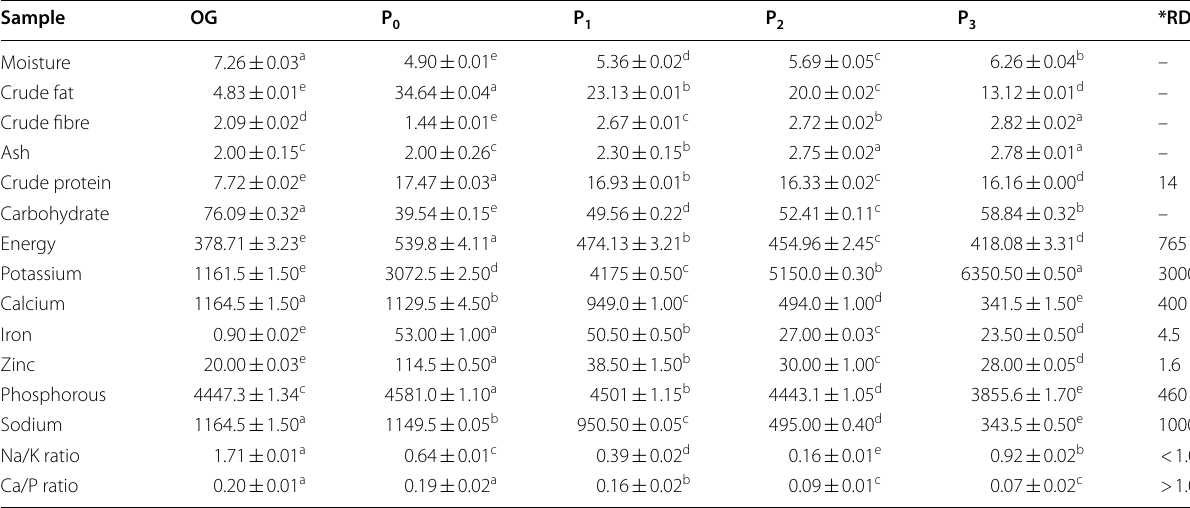
Values are mean of three determinations other ( p 0.05) ≤ *RDA (mg/day) (PAHO